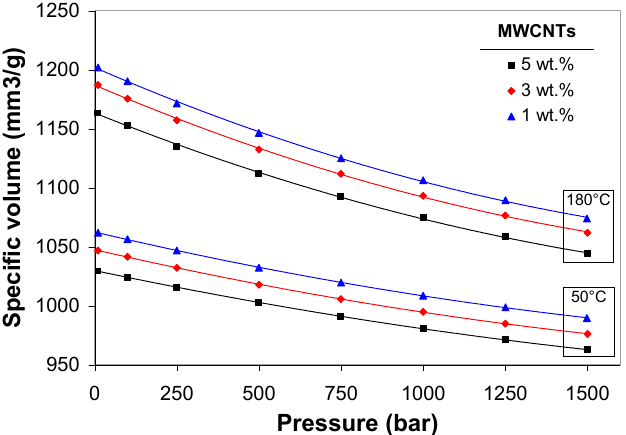
Figure 8. E ff ect of MWCNT wt.% and temperature on the specific volume in melt and solid Figure 8. Effect of MWCNT wt.% and temperature on the specific volume in melt and solid state.